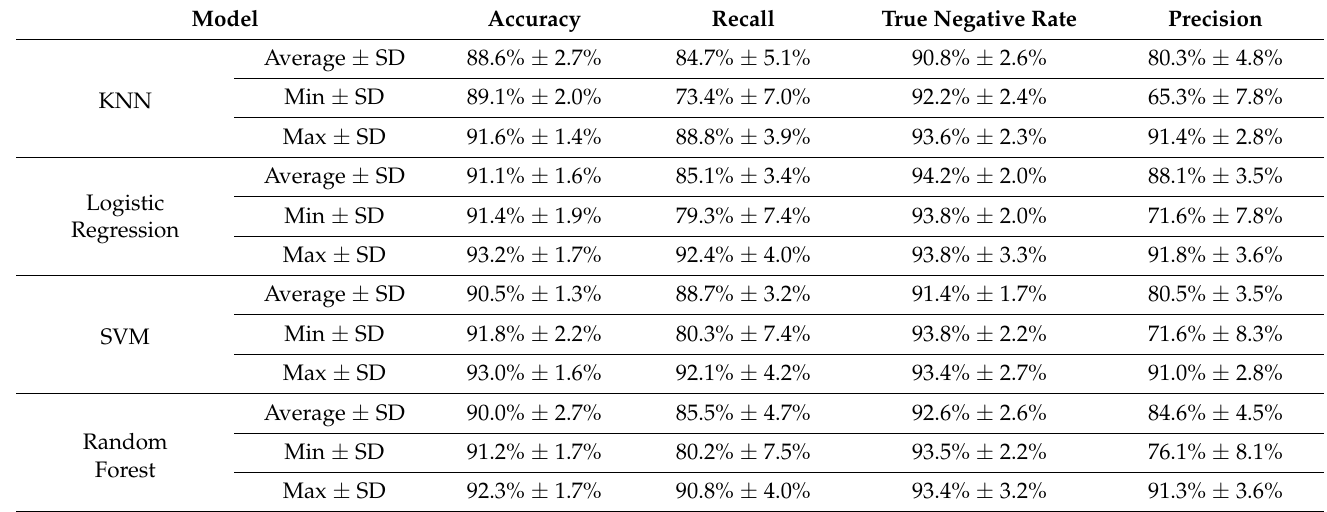
Table 3. Test results of machine learning